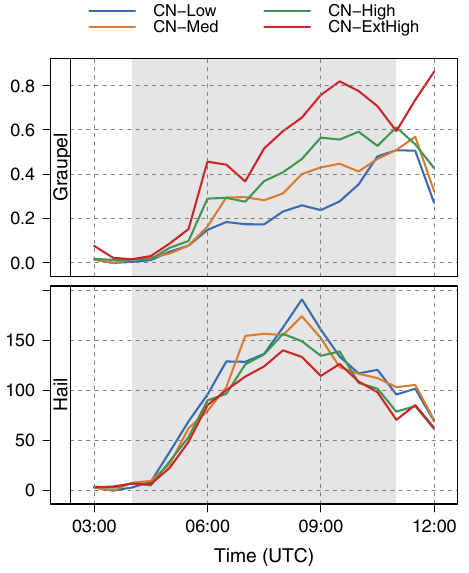
Figure 15. As in Fig. 11, but for graupel and hail mixing ratios.